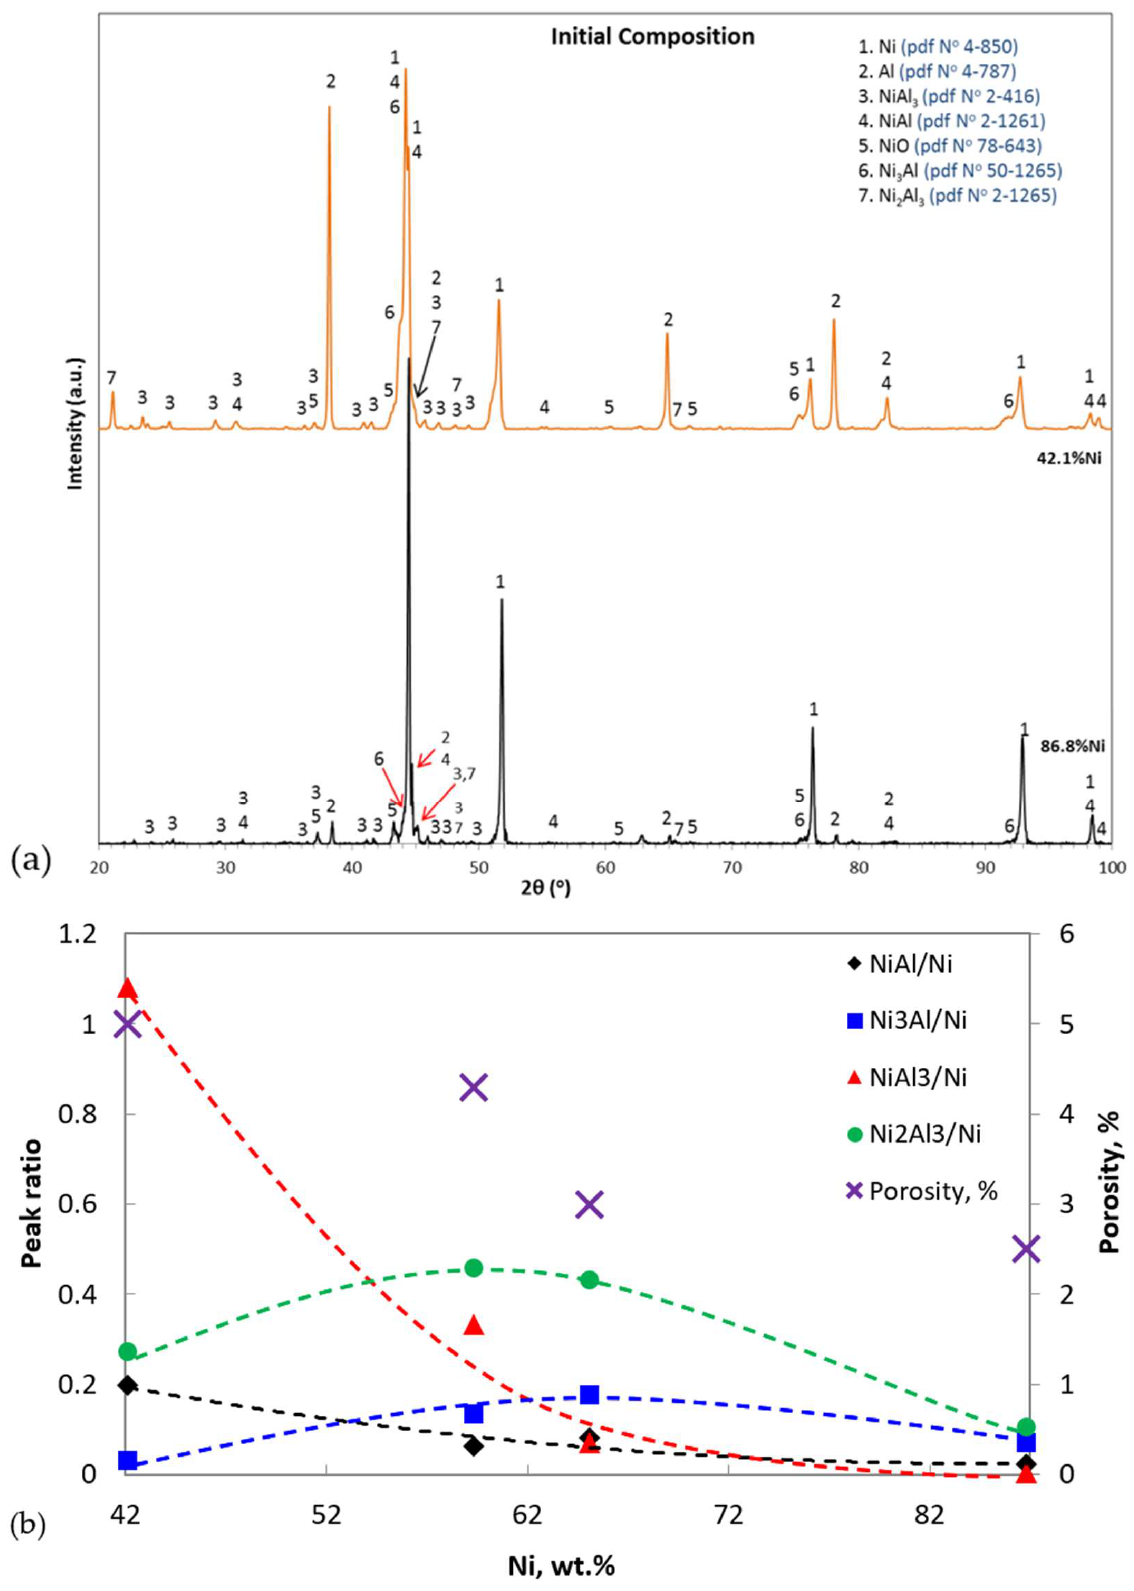
Figure 2. ( a ) XRD pattern of the surfaces formed after different initial composition of the powder before CAFSY (using data of [52]) and ( b ) coating porosity and semiquantitative analysis of the intermetallic phases present in the coatings as functions of the Ni content in the initial feedstock mixture.